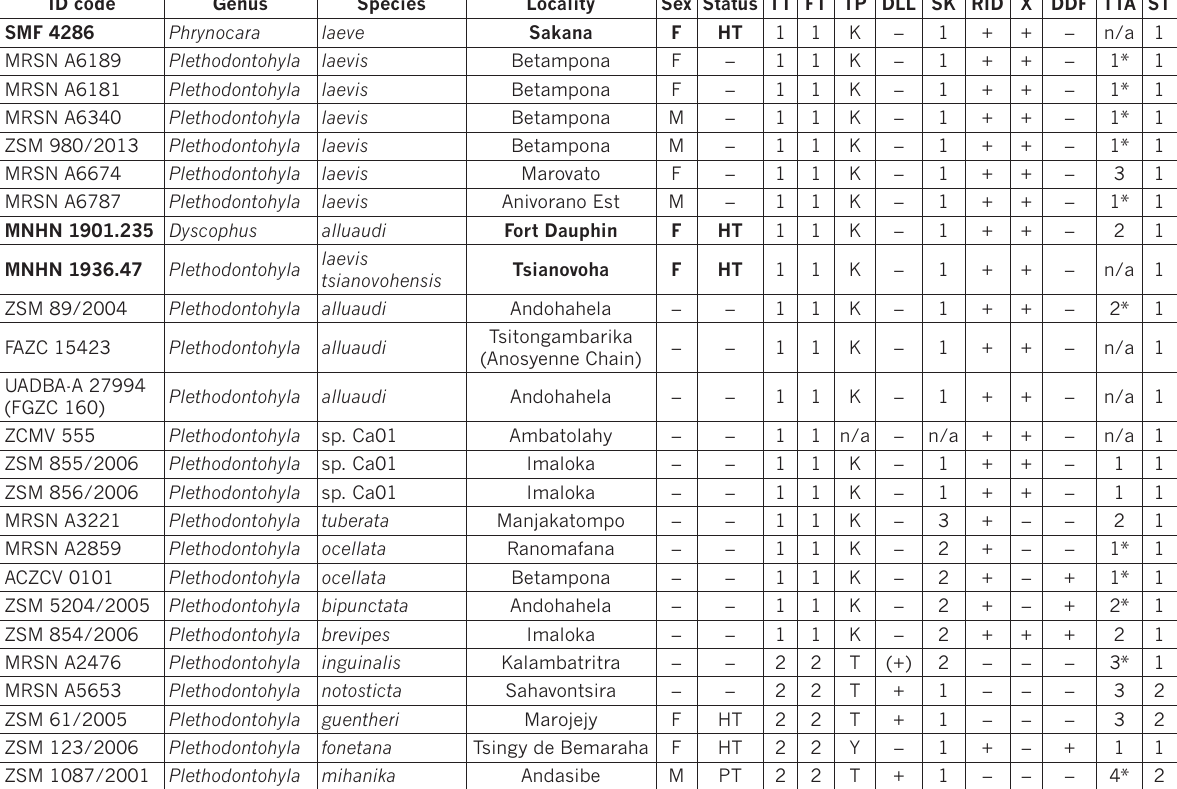
Table 5. Morphological variation in the analysed specimens of Plethodontohyla spp. Abbreviations not identified in the text: TT, Toe Tips (1, not enlarged, 2, enlarged); FT, Finger Tips (1, not enlarged, 2, enlarged); TP, Terminal Phalanges (K, knob-shaped, T, T-shaped, Y, Y-shaped); DDL, Dorsolateral Line, a narrow white dorsolateral line delimiting a sharp difference between the dorsal colouration and the uniformly dark flanks, extending from the tip of the snout backward until the inguinal region (+, presence, - absence, (+), not always present); Sk, Skin (1, smooth, 2, granular, 3, with tubercles); RID, Ridge, supratympanic dermal fold (+, presence, - absence); X, bold ‘X’ marking on the head between the eye bordered by a thin while line (+, presence, - absence); DDF, Dorsal Dermal Folds, two symmetrical and concave thin dorsal folds (+, presence, - absence); TTA, Tibiotarsal Articulation (1, reaching the tympanum, 2, reaching the insertion of the arms, 3, reaching the eye, 4, extending beyond the eye, * at least); ST, Snout tip (1, rounded, 2, pointed).